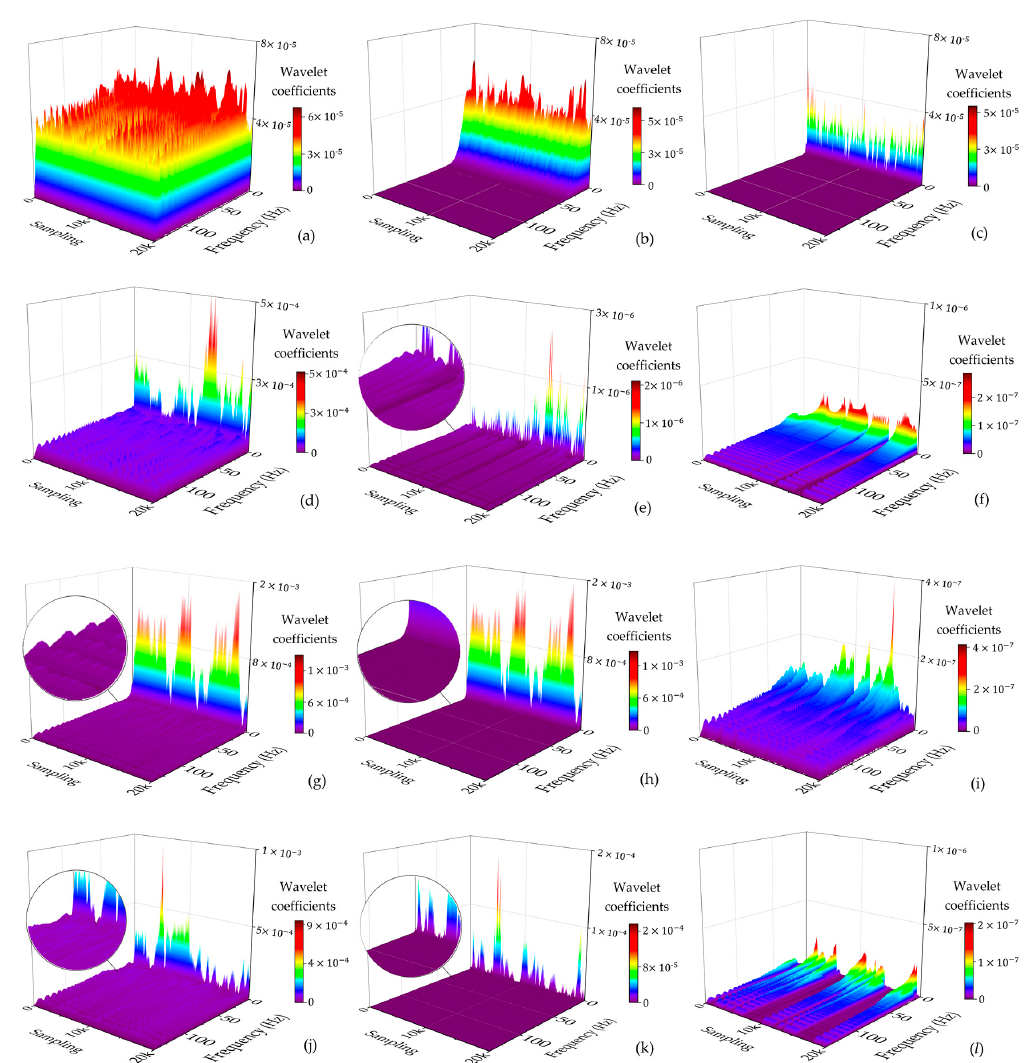
Figure 8. 3D time-frequency spectra of four types of signals under different decomposed levels: ( a ) steady (level = 0); ( b ) steady (level = 3); ( c ) steady (level = 6); ( d ) periodic (level = 0); ( e ) periodic (level = 8); ( f ) periodic (level = 12); ( g ) jitter (level = 0); ( h ) jitter (level = 6); ( i ) jitter (level = 9); ( j ) jumping (level = 0); ( k ) jumping (level = 7); ( l ) jumping (level = 10).